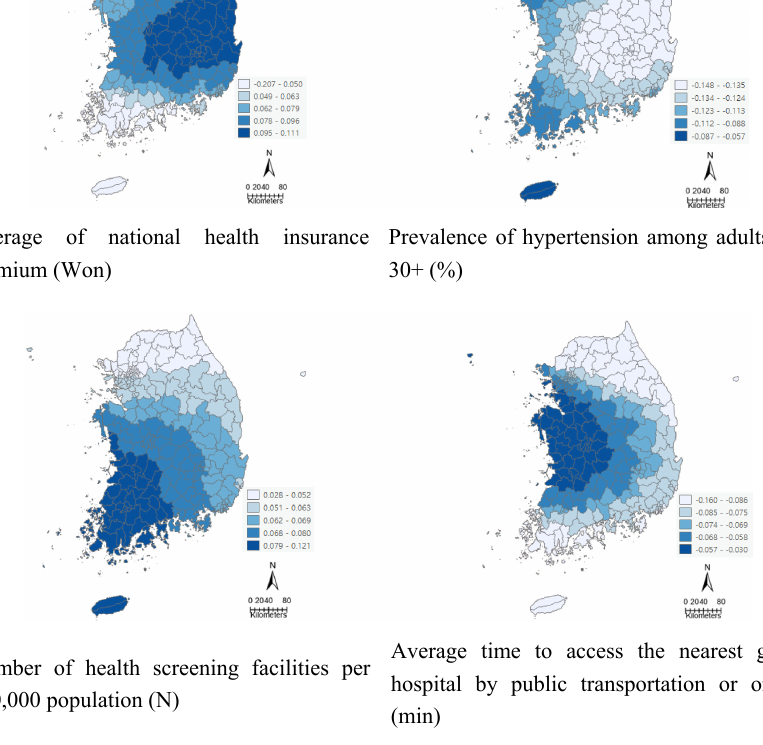
Fig. 3 GWR model coe ffi cients for the six selected variables in 229